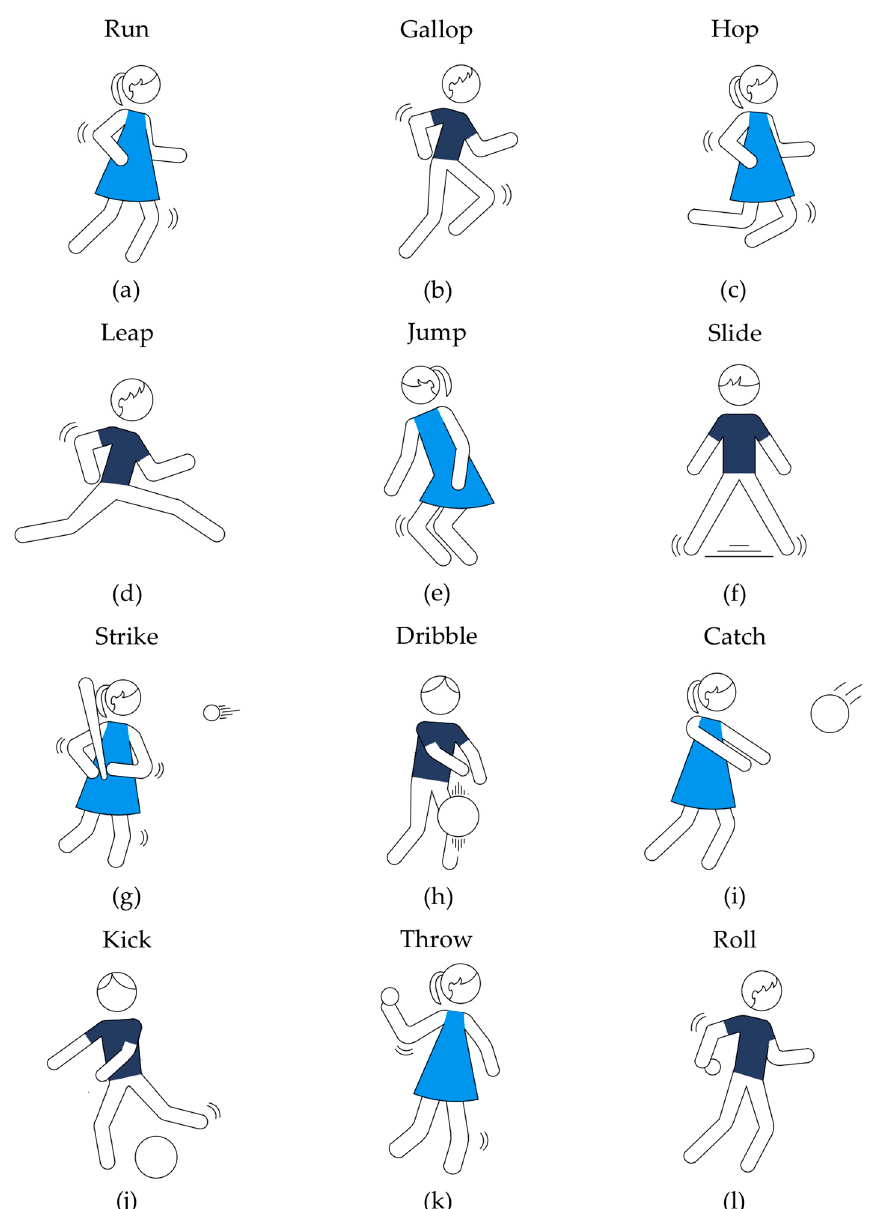
Figure 5. Test of Gross Motor Development—Second Edition. The test consisted of two subtests, each with six diverse aspects of gross motor development: ( a – f ) includes tasks in the locomotor subtest, and ( g – l ) includes tasks in the object control subtest. Three trials were conducted for each of the 12 items—one practice and two assessed.